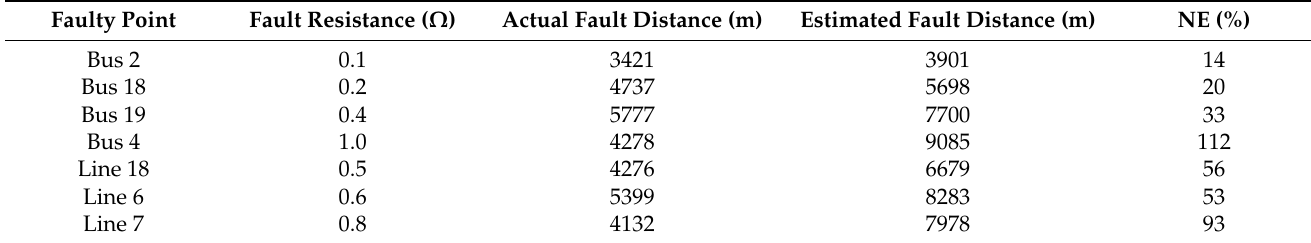
Table 2. Results of estimated fault location by distance relay for different scenarios.